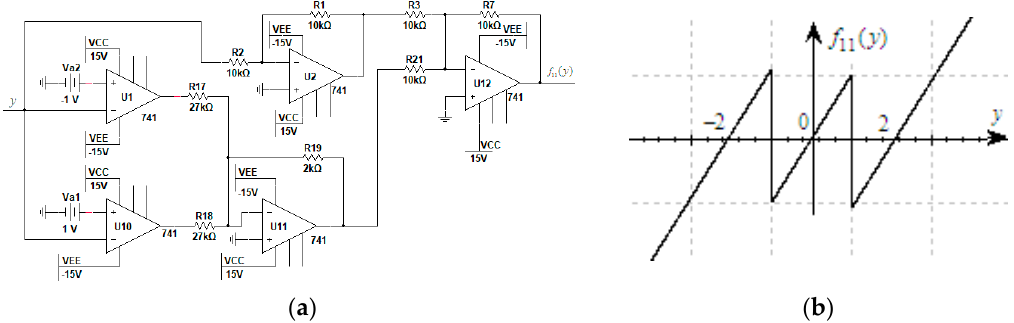
( ) f y with 0 N = and 1 B = : ( a ) 11 11